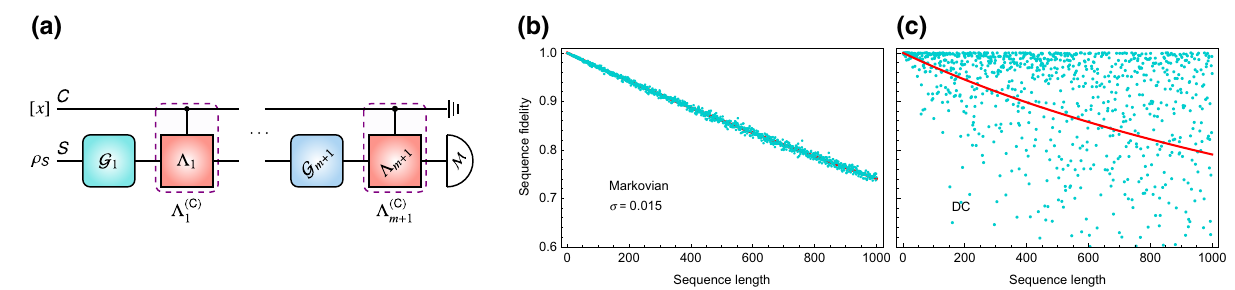
FIG. 11. Classical non-Markovian noise . (a) A RB sequence with classical non-Markovian noise for an initial state ρ S , gates { G i } and final measurement M . Correlations are determined by a classical stochastic process [ x ], whose output at each step i controls the . We reproduce the ASF in Ref. [30] for classical dephasing noise in the corresponding error map (cid:3) i on S giving some other map (cid:3) ( C ) i cases of (b) classical Markovian noise and (c) classical dc noise with a standard deviation σ = 0.015; in both cases (teal) dots represent numerical averages over 100 samples and the solid (red) curve is the analytical